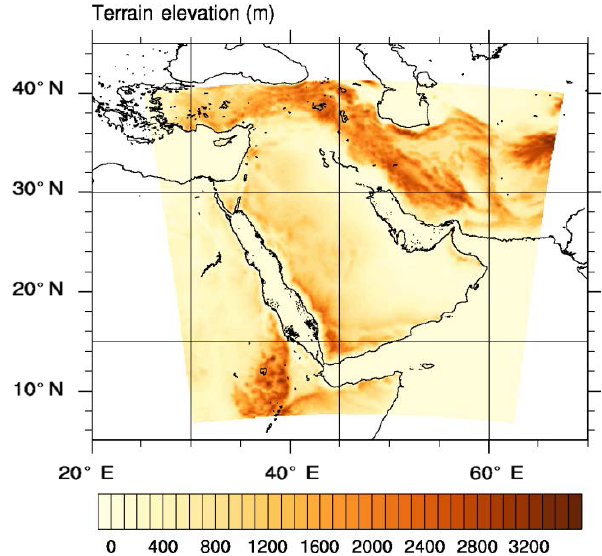
Figure 1. DREAM model domain and topography in